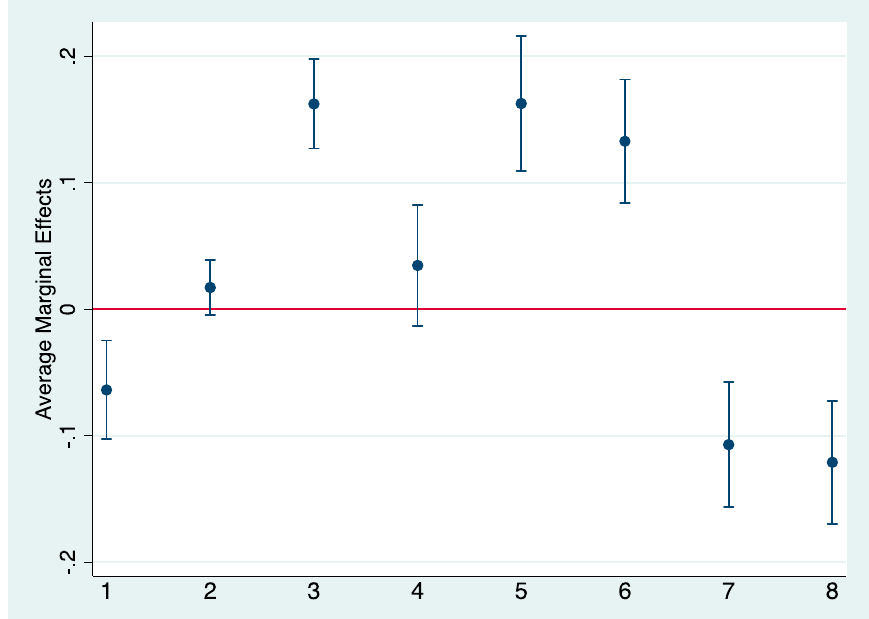
Figure 1. Bivariate Associations between Mothers’ Early Childbearing and Covariates. Note. All covariates are binary. 1 = Coresident Mother and Father 2 = Mother Had Psychological Problems; 3 = No Household Member with Upper Secondary School 4 = Mother Worked; 5 = Working Class; 6 = Family Received Welfare; 7 = Families Attitudes Toward Higher Education (range = 1–7); 8 = Daughters’ School Performance (range = 0–10).